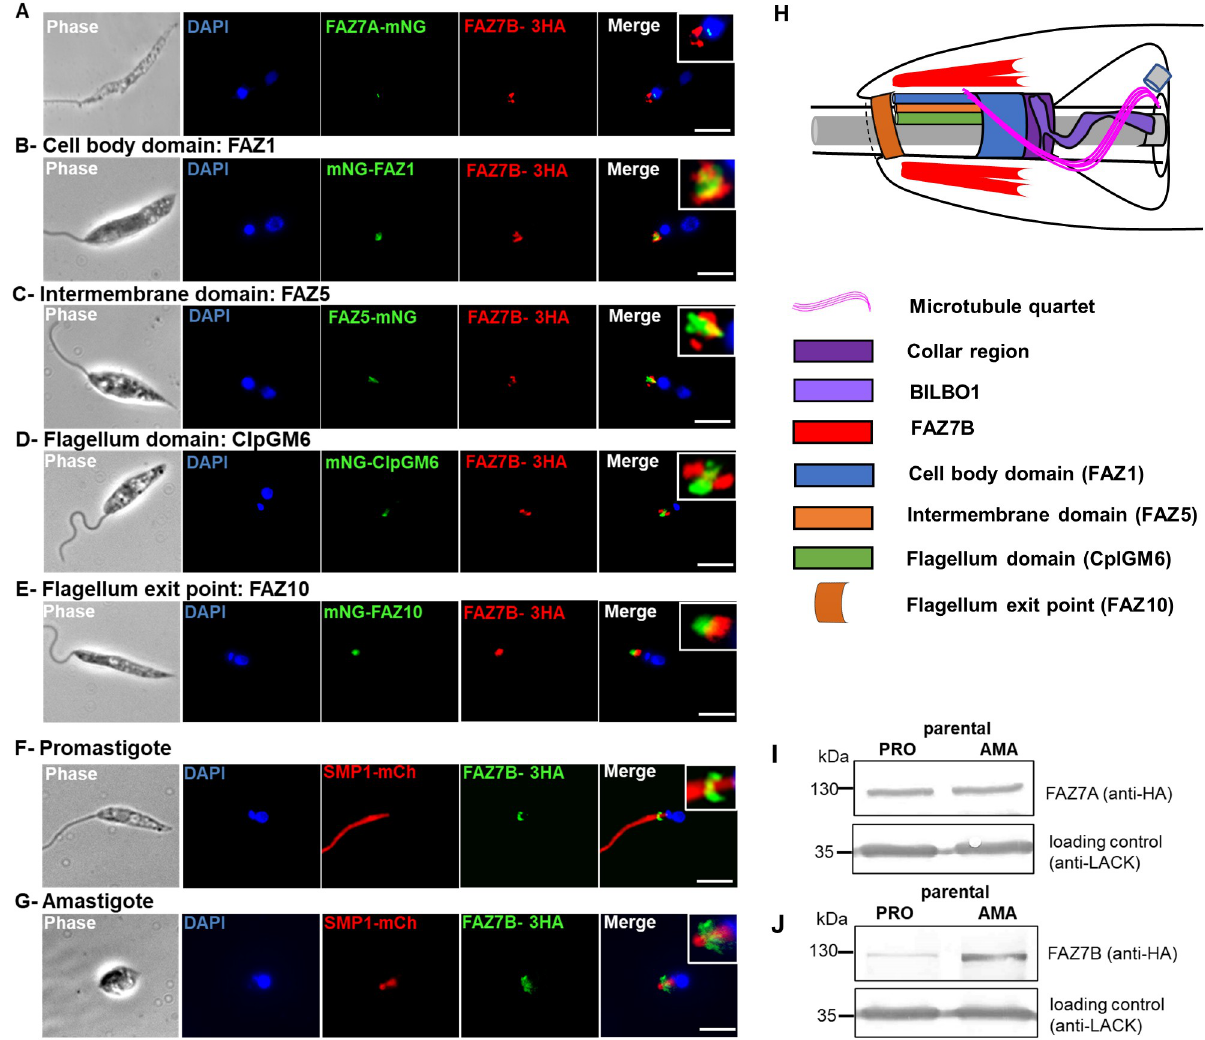
Fig 1. L . mexicana FAZ7B localizes at the cell body side of the FAZ and is differentially expressed in promastigote and amastigote forms. Immunofluorescence assay were performed as indicated in Materials and Methods. (A) Extracted cytoskeleton of a L . mexicana promastigote expressing FAZ7A-mNG (green) and FAZ7B-3xHA (red). (B-E) Whole promastigote cells of L . mexicana expressing FAZ7B-3xHA (red) and the indicated fusion proteins of FAZ components (green). (F-G) Whole promastigote (F) and axenic amastigote (G) cells from L . mexicana expressing FAZ7B-3xHA (green) and the flagellar membrane marker SMP1-mCh (red). DNA was labelled with DAPI (blue). Scale bar: 5 μ m. (H) Schematic of the FAZ protein localisations and anterior cell tip organisation in a promastigote cell, providing a side-on view of the FAZ (as inferred from our data and adapted from Halliday et al., PLoS Pathog 16(10): e1008494). The flagellar pocket is divided into two regions (bulbous and neck) joining by the flagellar pocket collar region; the microtubule quartet (MTQ) starts at the basal bodies and wraps around the bulbous region of the flagellar pocket before terminating in the neck region. The different FAZ domains and the proteins analysed in the present study are shown. Not to scale. (I-J) Western blot of promastigotes (PRO) and axenic amastigotes (AMA) of the parental cell line expressing FAZ7A-3xHA (I) and FAZ7B-3xHA (J); 35 μ g of total protein extract were loaded on a 12% SDS-PAGE, transferred and immuno-probed with anti-HA and anti-LACK (loading control) antibodies. tagged basal body protein Centrin4 (S2A Fig) [22]. By contrast, FAZ7B was present as a rela- tively heterogeneous signal at the anterior end of the cell body (Fig 1), consistent with a locali- zation at the FAZ [4]. The fluorescence signal of both proteins remained associated with extracted cytoskeletons, suggesting that both are cytoskeletal proteins (Fig 1A). To better define this localization, we tagged the SMP1 flagellum membrane marker [23] with mCh to map the FP organization [4] and performed cell imaging at different planes in the z-axis.